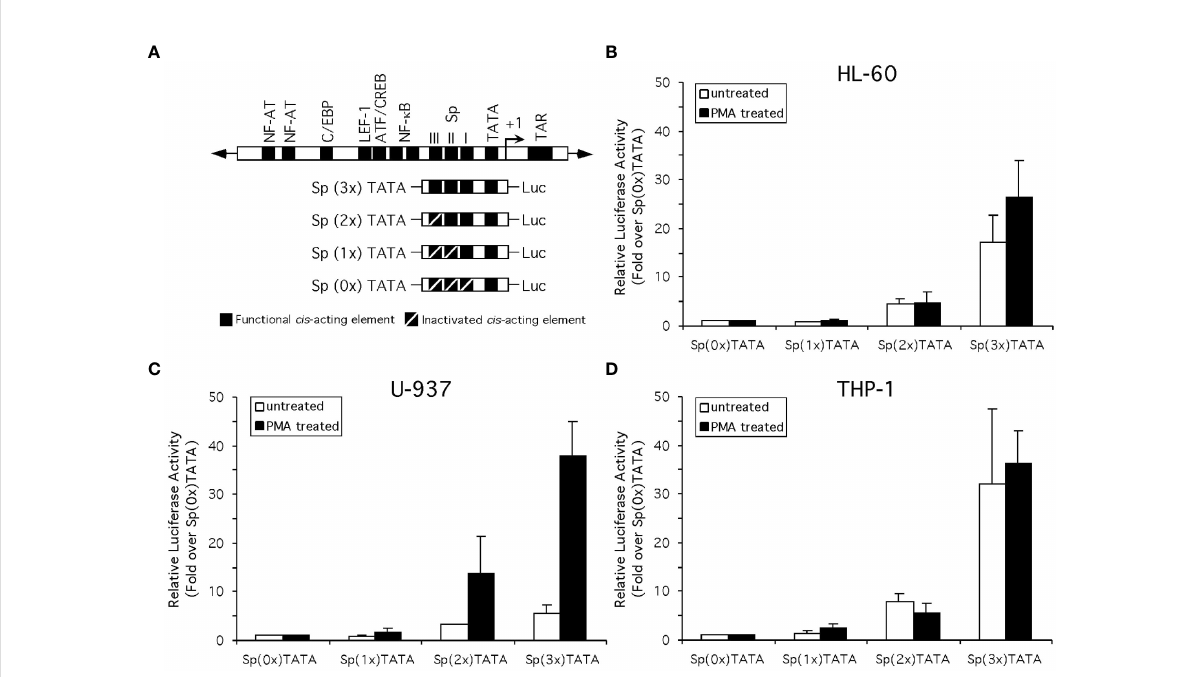
FIGURE 8 Altered Sp factor binding correlated with chemical differentiation alters the activity of the Sp elements of the HIV-1 LTR. (A) Diagrammatic depiction of the truncated LTR-Luciferase constructs examined. (B) Standard reporter gene analysis utilizing the dual luciferase reporter gene system (see Materials and Methods for details) was employed to determine the effect of chemically-induced monocytic differentiation on the activity of constructs containing three, two, one or no active Sp cis -acting elements. Results compare the activity of constructs in the HL-60 (B) , U-937 (C) , and THP-1 (D) cells in the absence or presence of PMA treatment. Activity is shown as fold-increase over the Sp(0x)TATA construct. Individual experiments were performed in duplicate and repeated at least three times. Error bars represent the standard